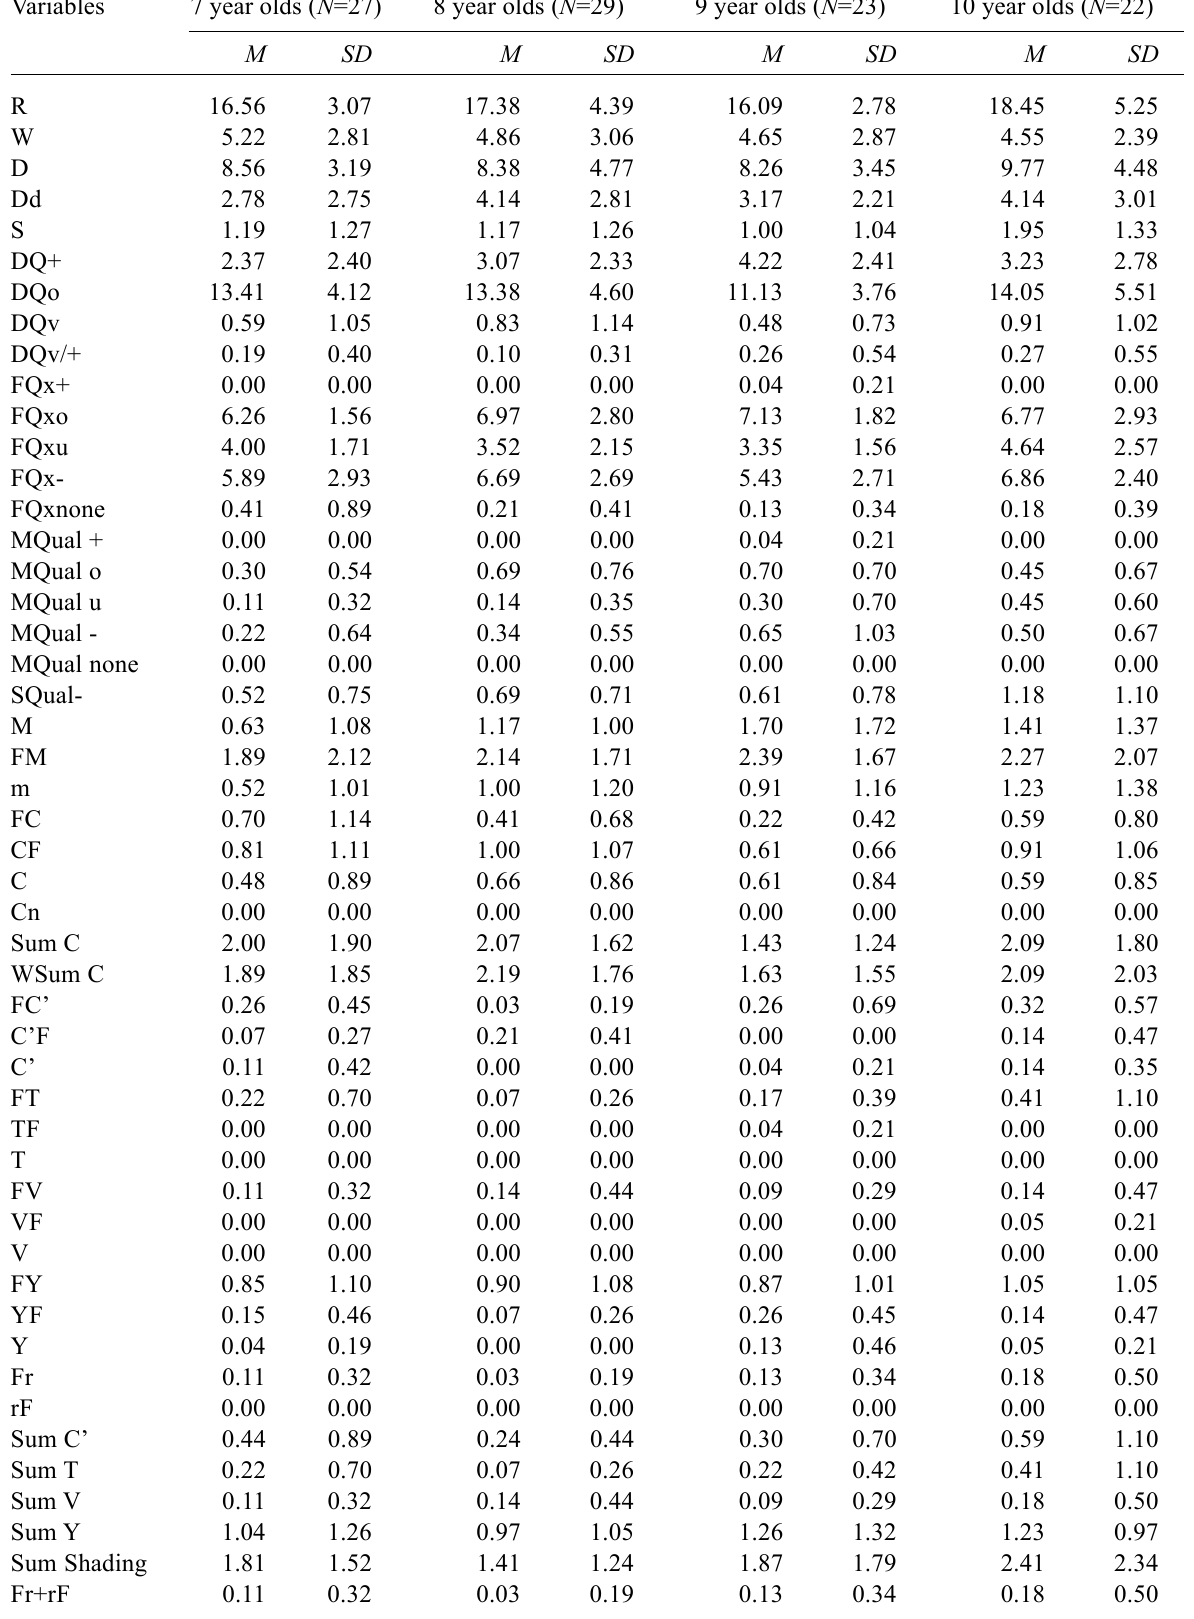
Statistical Distribution of the 113 Rorschach Variables of Children from Private Schools (N = 101)